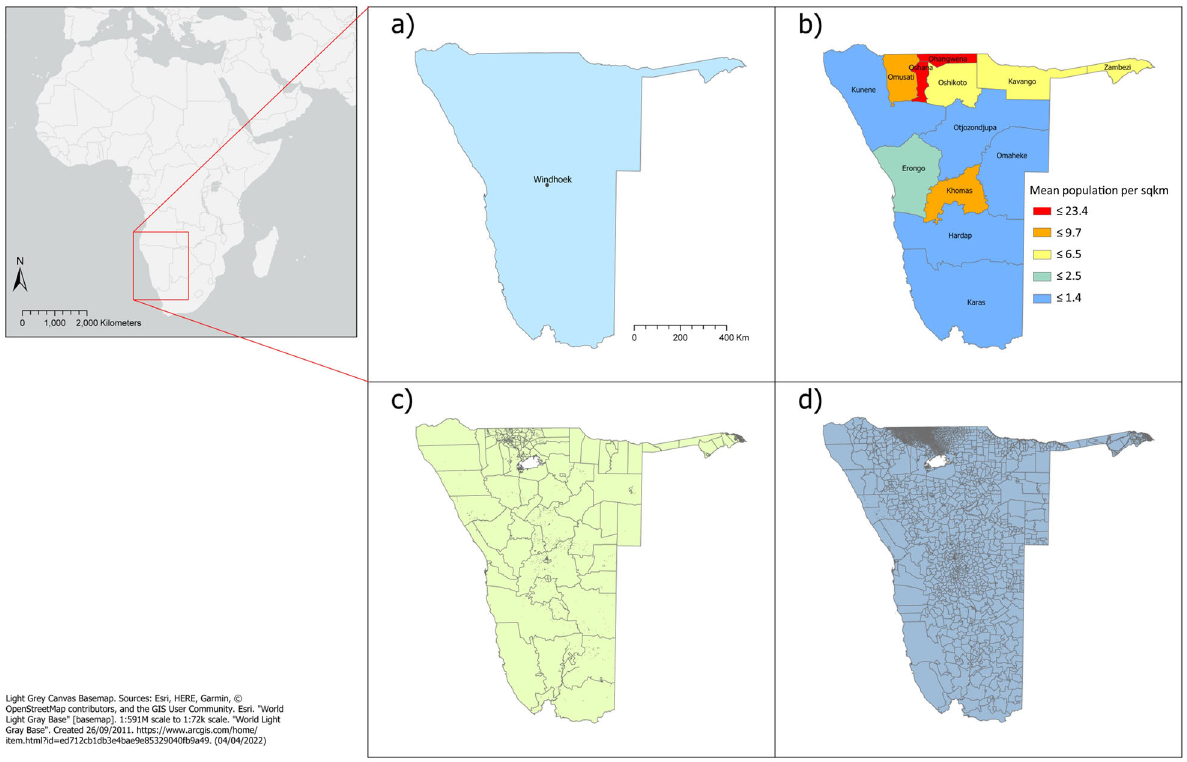
Fig. 1 Overview of Namibia and its divisions. a Administrative level 0 (country) with capital, b administrative level 1 (regions) with population density derived from WorldPop (2018), c administrative level 2 (constituencies), d administrative level 3 (enumeration areas) (GADM, 2022; WordPop, 2018).